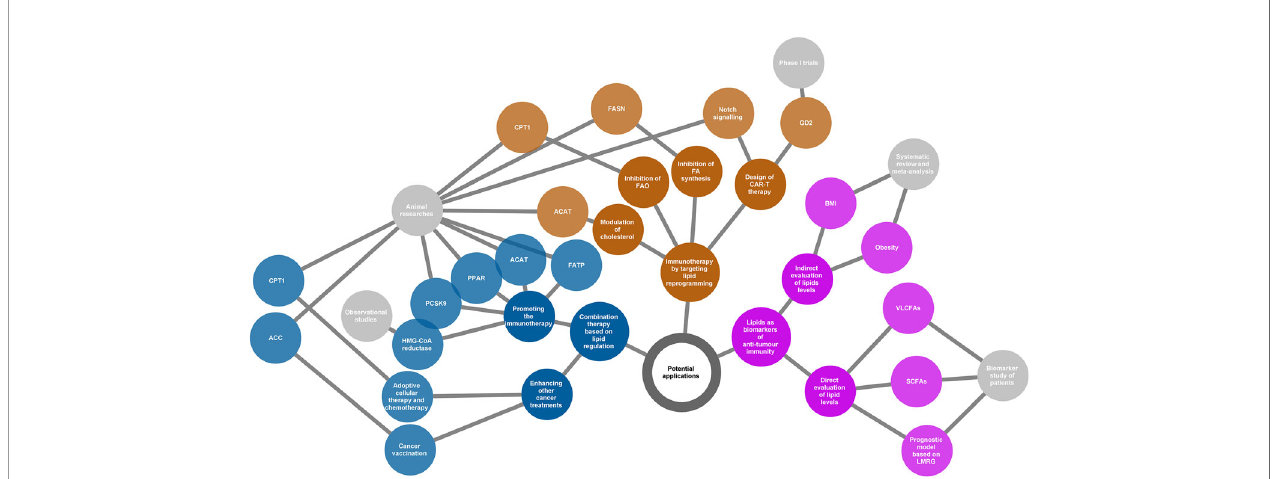
FIGURE 4 | Potential applications of the lipids according to their various roles in cancer immunity. Three directions presented (yellow, blue, and purple nodes) for potential applications as summarized in the network diagram. The grey nodes in the last level indicate evidence types supporting each application. The adjacently spread nodes next to the last nodes represent lipids-related therapeutic targets or biomarkers. ACC, acetyl-CoA carboxylase; ACAT, acetyl-CoA acetyltransferase; BMI, body mass index; CAR-T, chimeric antigen receptor T cell; CPT1, carnitine palmitoyltransferase 1; FA, fatty acid; FAO, fatty acid oxidation; FASN, fatty acid synthase; FATP, transport protein; GD2, a disialoganglioside glycolipid; LMRG, lipid metabolism-related genes; PCSK9, proprotein convertase subtilisin/kexin type 9; PPAR, peroxisome proliferator-activated receptor; SCFAs, short-chain fatty acids; VLCFAs, very long-chain fatty